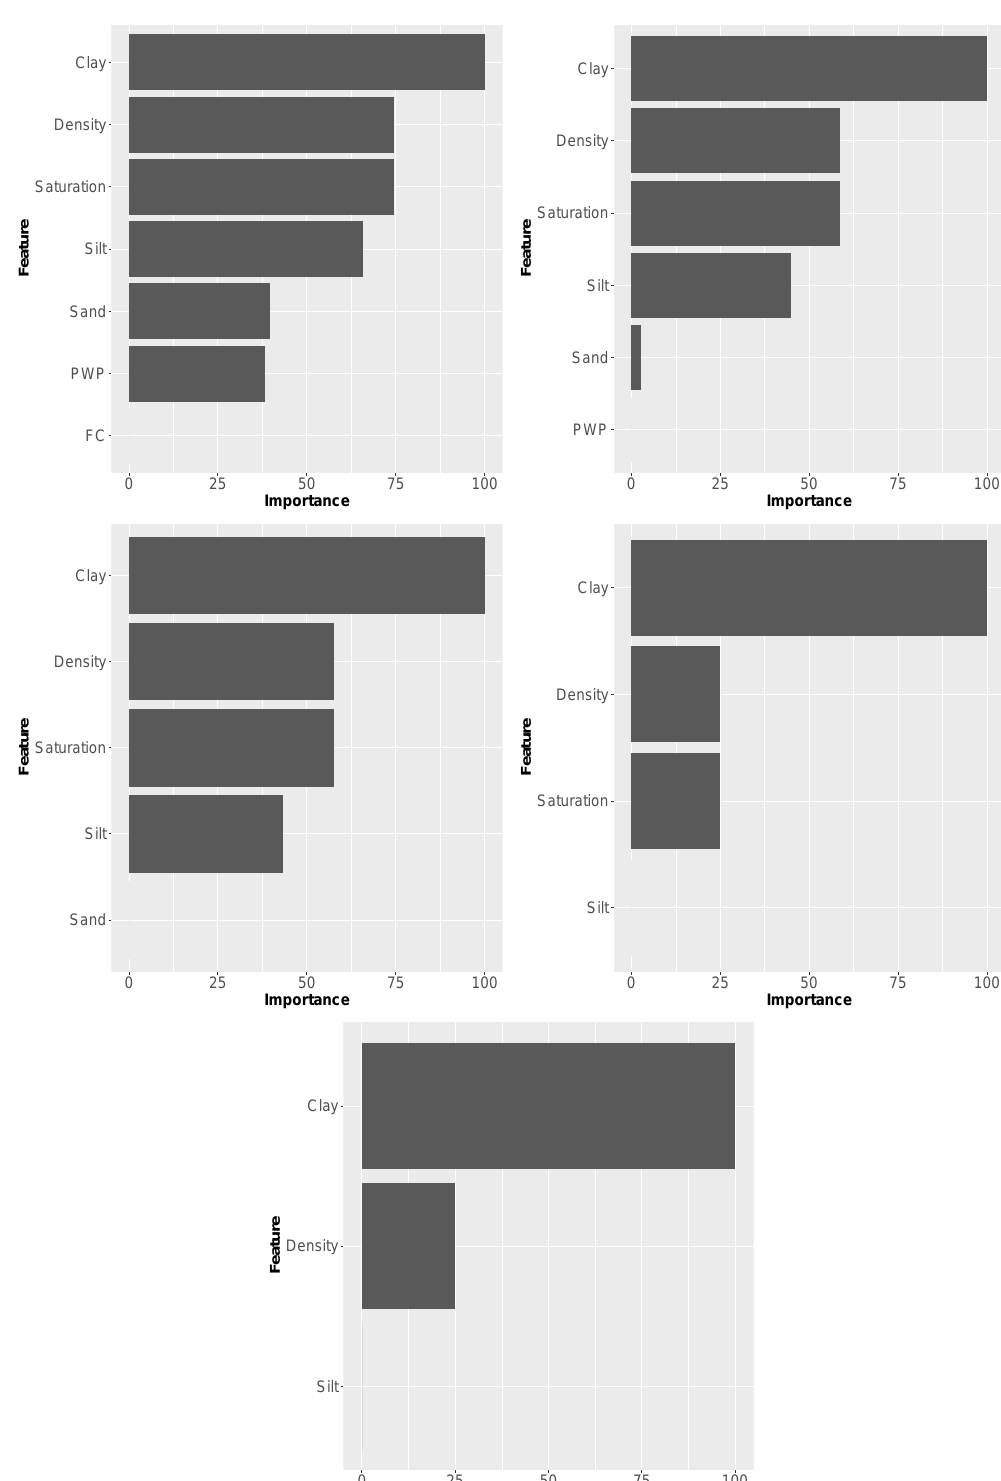
Figure 6. Importance plots referring to the weight of each variable in the calculations. From top to bottom and from right to left, the number of input data goes from 7 to